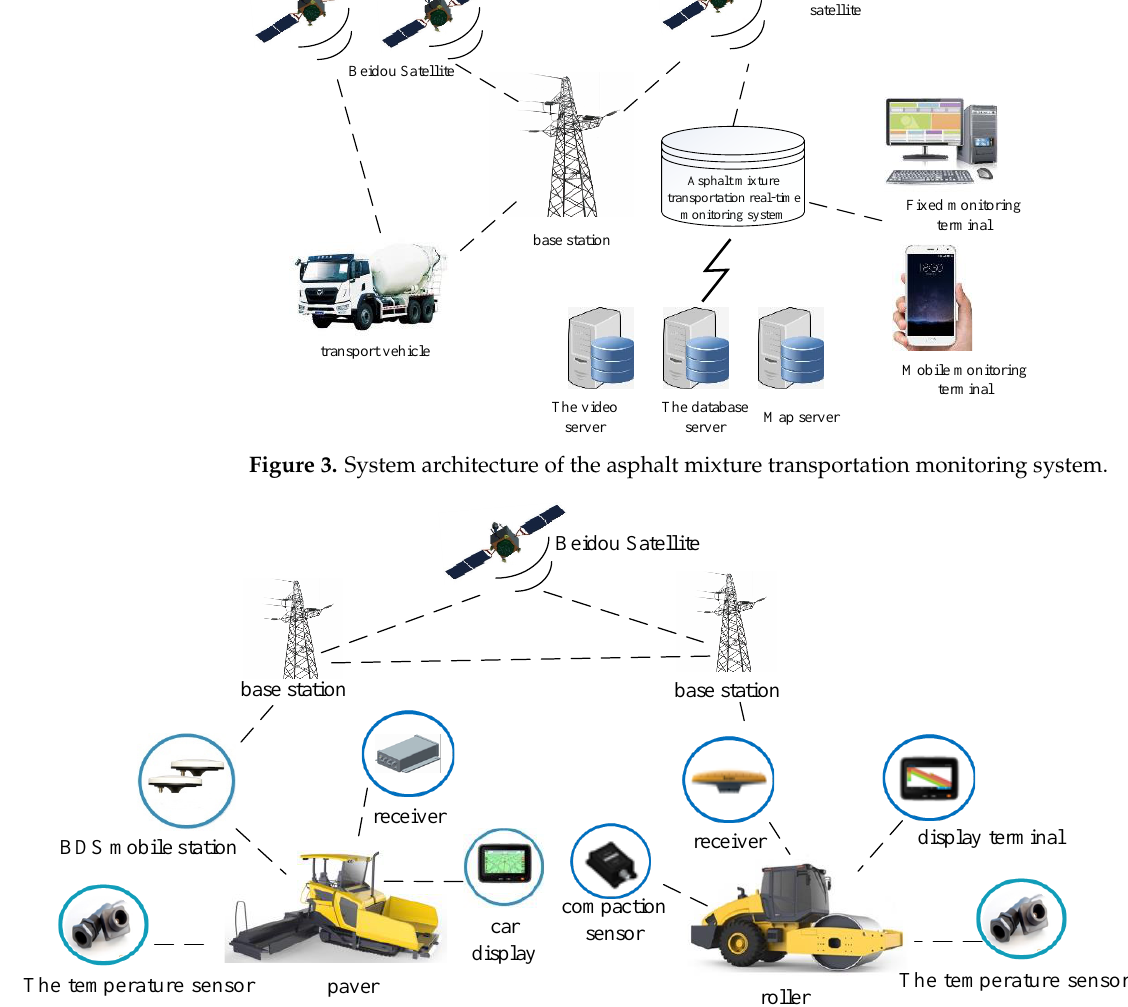
Figure 4. Asphalt pavement paver and roller after digital transformation.